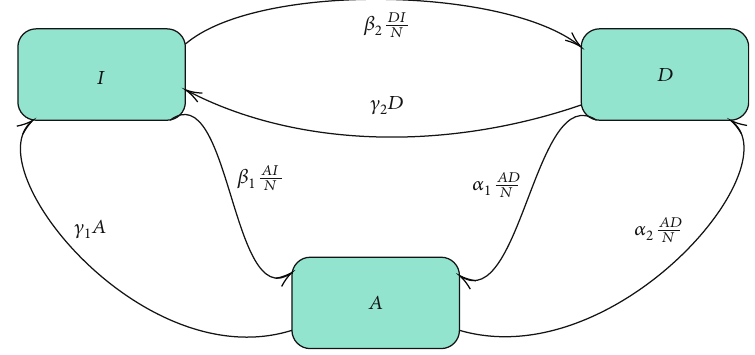
Figure 1: Flow chart for the model (1)-(3).